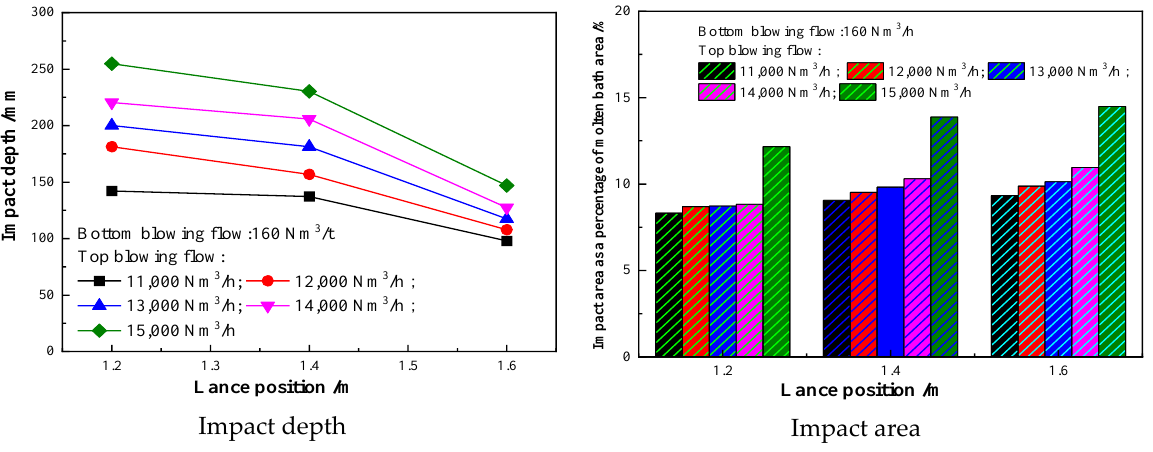
Figure 6. Variation of impact depth and impact area measured in the experiment. 3.3. Effect of Vanadium Extraction from Hot Metal before and after Process Optimization The bottom blowing process of vanadium extracting converter was optimized by using the circular seam bottom blowing gas supply element. After process optimization, with the increase in bottom blowing gas flow, the molten bath of vanadium extraction converter maintained a good stirring effect. The data before and after process optimization were compared, in which the data of the finished vanadium slag was 40 heats, and the data of semi-steel was 900 heats. The comparison of relevant process technical indicators is shown in Table 5. Table 5. Changes of main components and temperature of vanadium slag and semi-steel before and after process optimization.